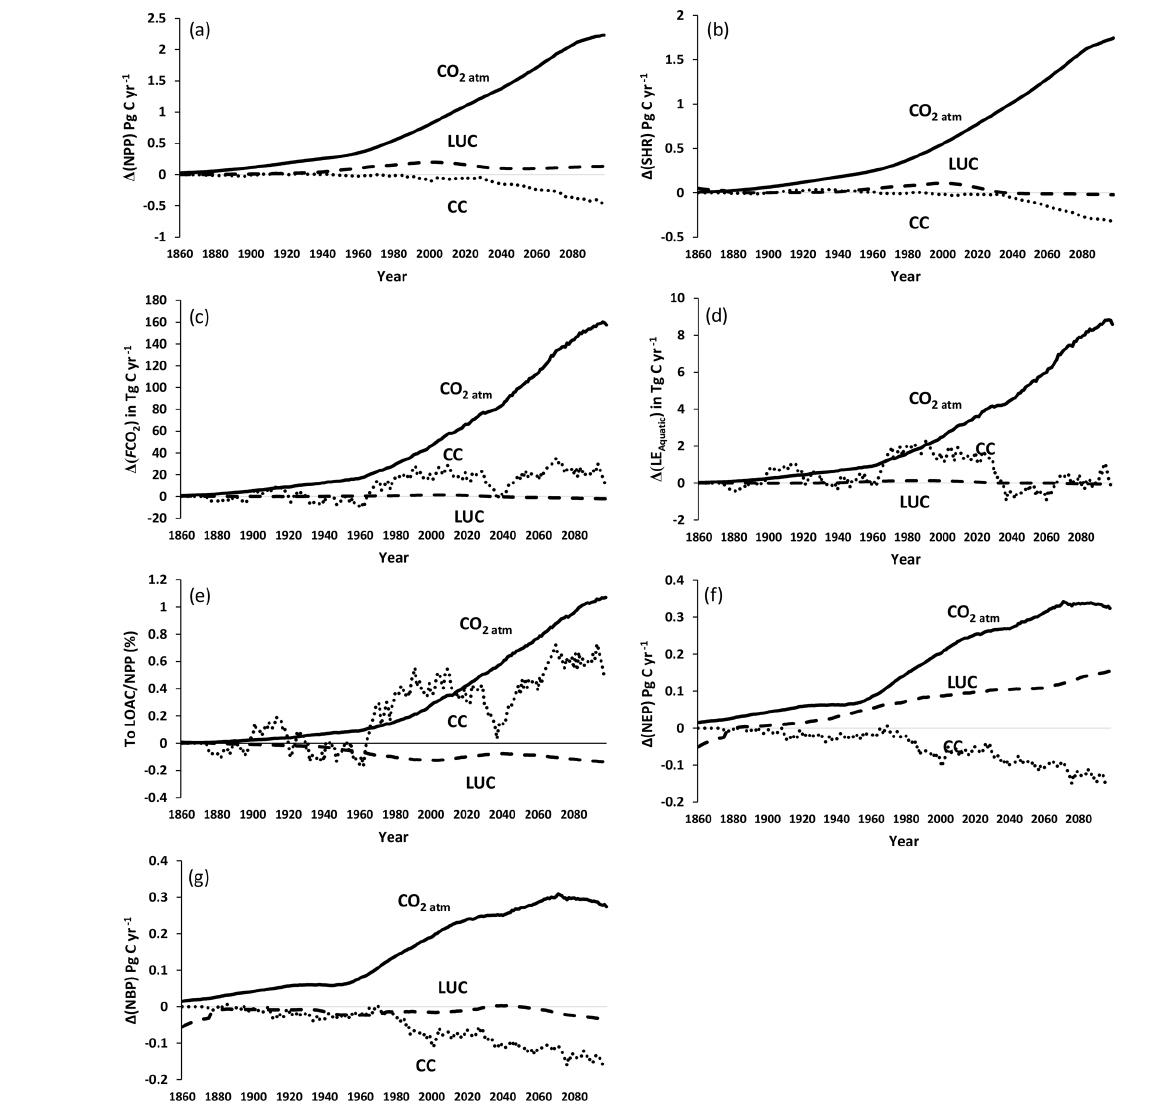
Figure 11. Contribution of the anthropogenic drivers atmospheric CO 2 concentration (CO 2atm ), climate change (CC), and land use change (LUC) to changes in the various carbon fluxes along the Congo Basin under IPSL-CM5A-LR model outputs for RCP6.0 (Frieler et al.,